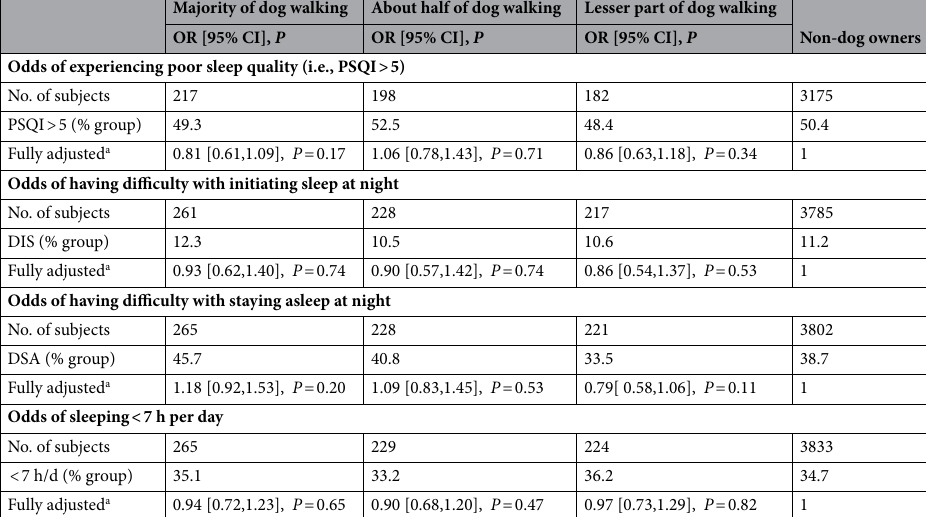
Table 3. Logistic regression analysis to investigate the association between dog walking and sleep in the SCAPIS cohort (Uppsala). CI, confidence interval; DIS, difficulty initiating sleep; DSA, difficulty staying asleep; No., number; OR, odds ratio; PSQI, Pittsburgh Sleep Quality Index. a Logistic regression was adjusted for the following variables: sex, education, age, BMI, social interaction, regular physical activity, alcohol frequency, socio-economic stability, night shift work, diabetes, sleep apnea, constant stress, current smoking.